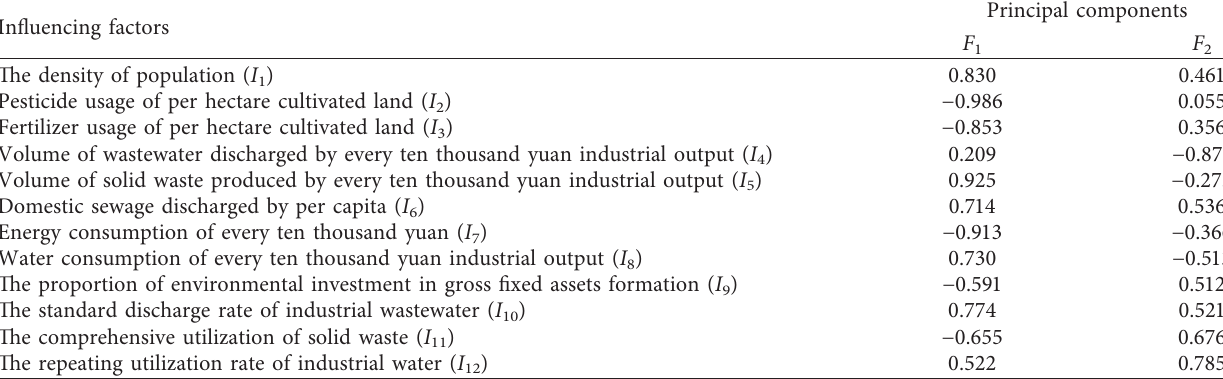
Table 6: Factor load matrix of principal components.